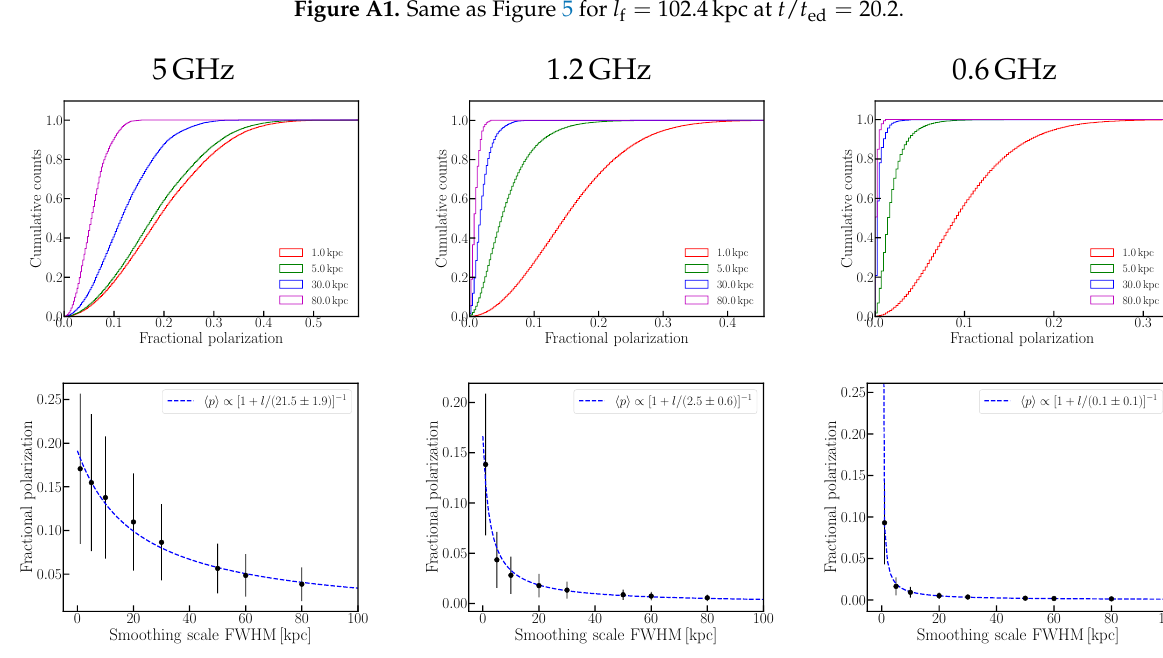
Figure A2. Same as Figure 5 for l f = 64kpc at t / t ed =